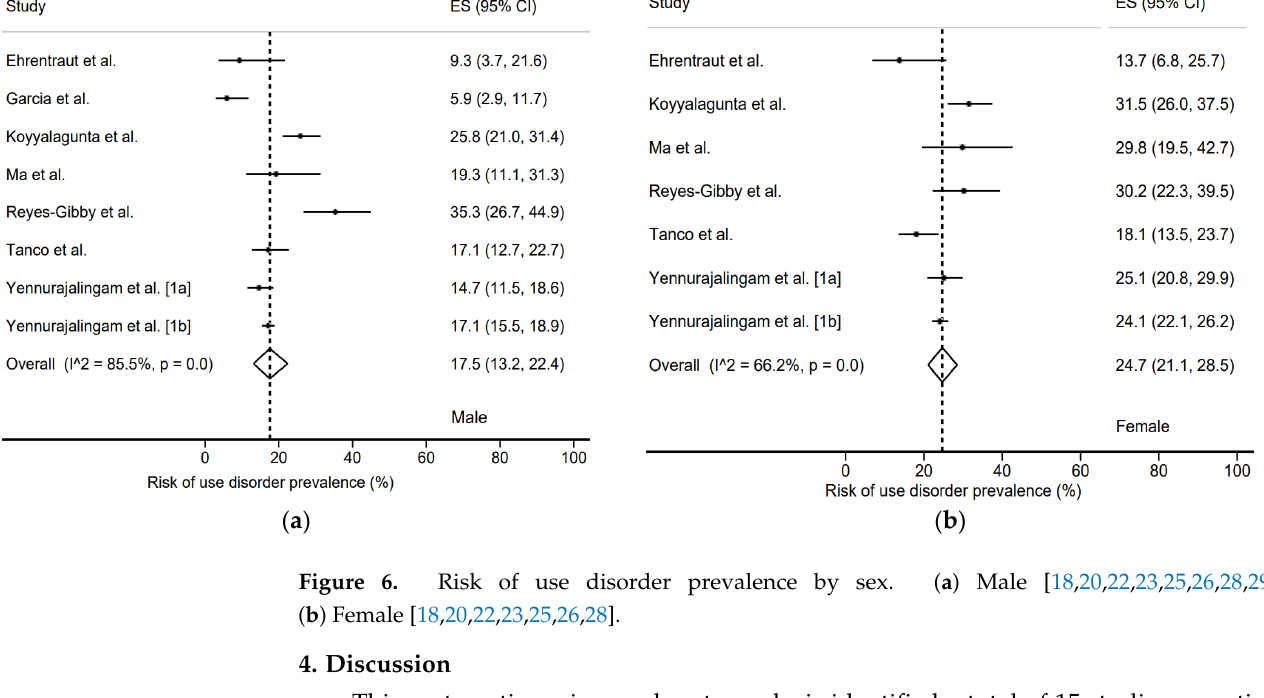
Figure 6. Risk of use disorder prevalence by sex. ( a ) Male [18,20,22,23,25,26,28,29]; ( b ) Female [18,20,22,23,25,26,28].